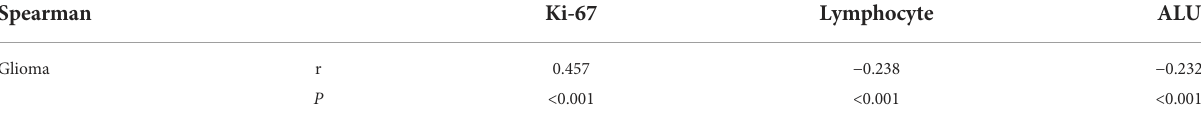
TABLE 4 Spearman correlation analysis independent risk factors with HGG in all cohorts.